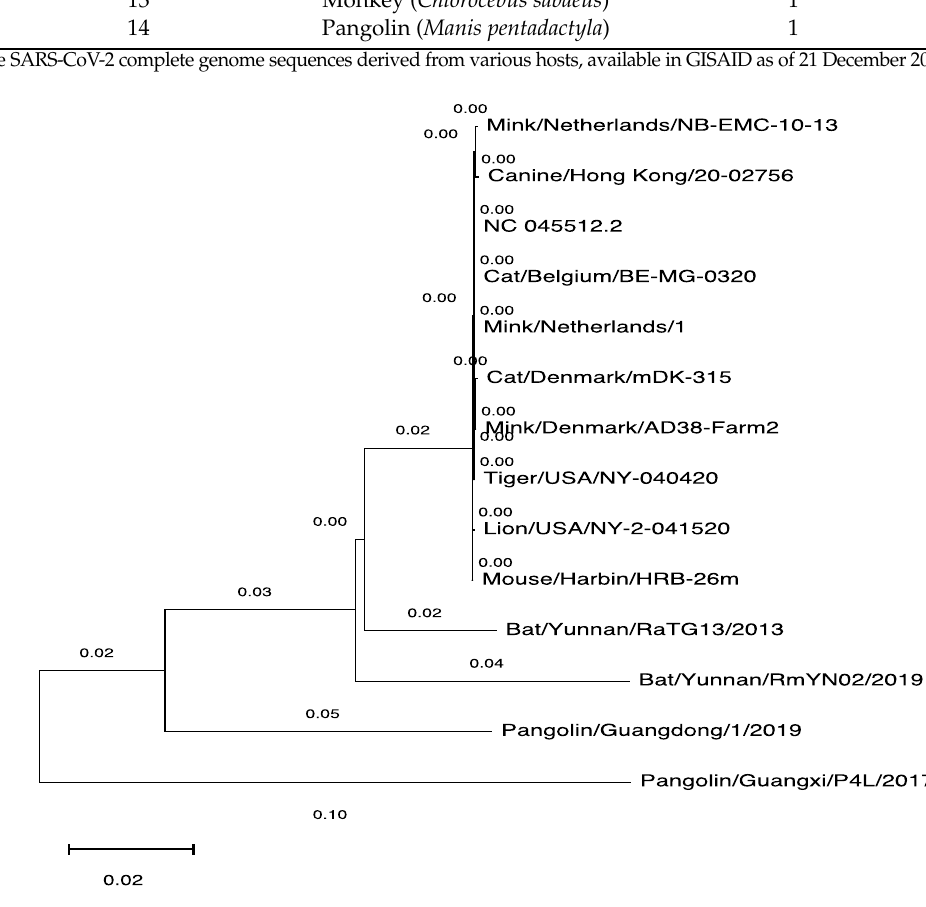
Figure 1. Phylogenetic tree of the SARS-CoV-2 genomes derived from various hosts. The MEGAX software tool was used to generate the phylogenetic